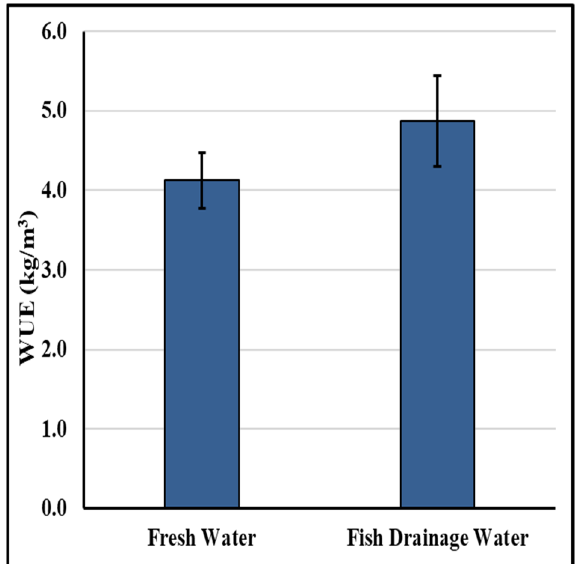
Figure 3. Effect of fresh and fish drainage water in combination with organic fertilizers on water use efficiency (WUE).